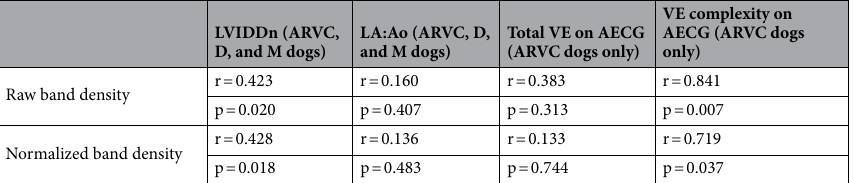
Table 3. Correlation between echocardiographic measurements and anti-desmoglein-2 antibody concentration in all dogs with cardiac disease are shown. Correlation between ventricular ectopy (VE) burden and complexity and auto-antibody expression for Boxers with ARVC are also